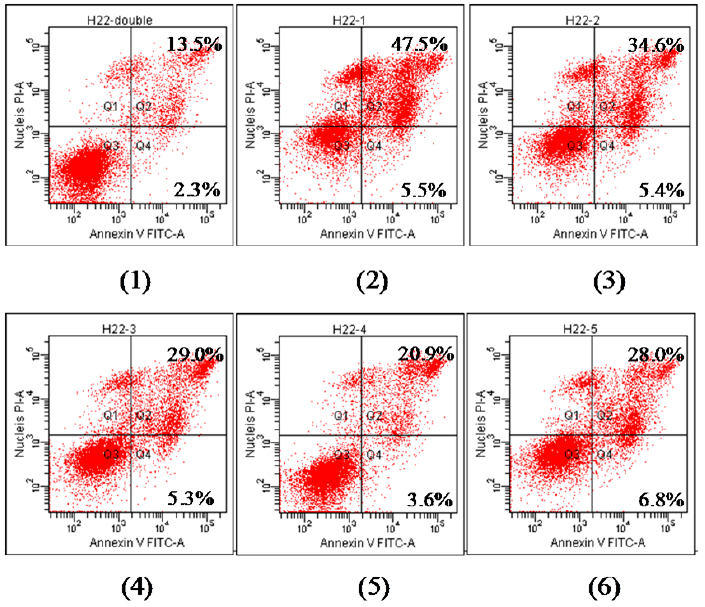
Figure 3 . Effects of 7a ‒ 7e on cell apoptosis of H22 for 48 h: ( 1 ) control; ( 2 ) 7a , 3 μ M; ( 3 ) 7b , 3 μ M; ( 4 ) 7c , Figure 3. Effects of 7a – 7e on cell apoptosis of H22 for 48 h: ( 1 ) control; ( 2 ) 7a , 3 µ M; ( 3 ) 7b , 3 µ M; ( 4 ) 7c , 3 μ M; ( 5 ) 7d , 3 μ M; and ( 6 ) 7e , 3 μ M. 3 µ M; ( 5 ) 7d , 3 µ M; and ( 6 ) 7e , 3 µ